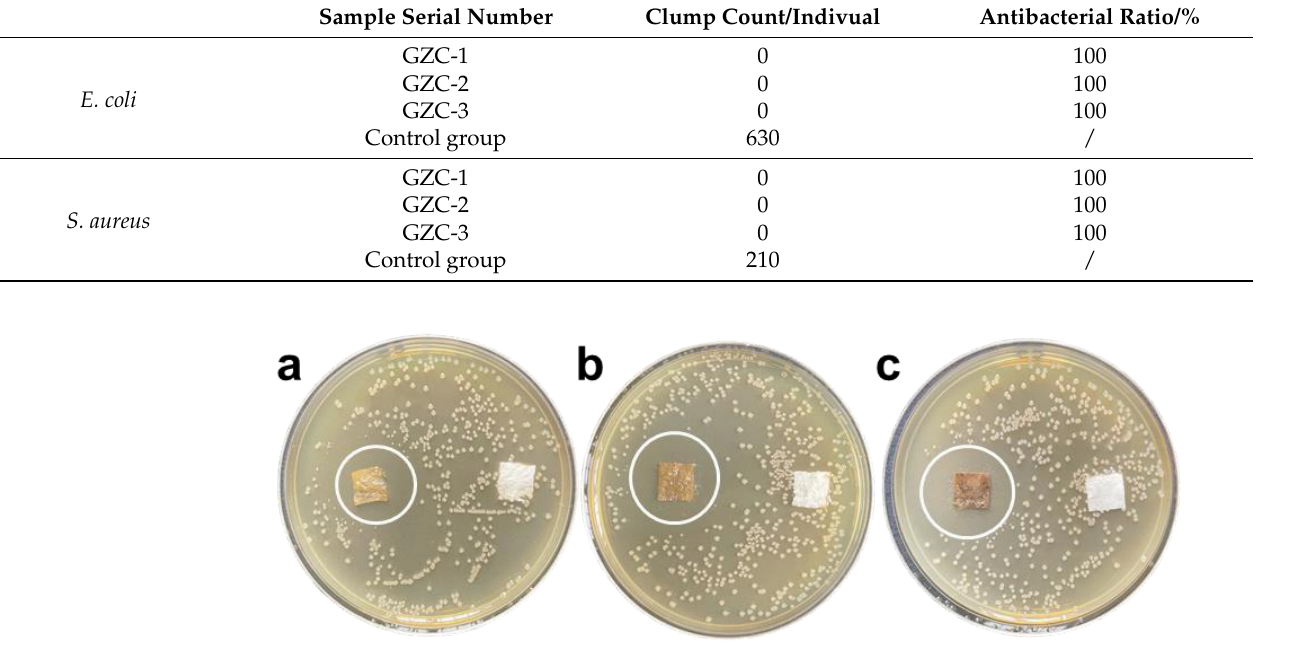
Figure 5. Antibacterial zone diagram of composite antibacterial coating on E. coli ; the mass frac- tions of GZC antibacterial powder are 1% ( a ), 3% ( b ), and 5% ( c ) in sequence.